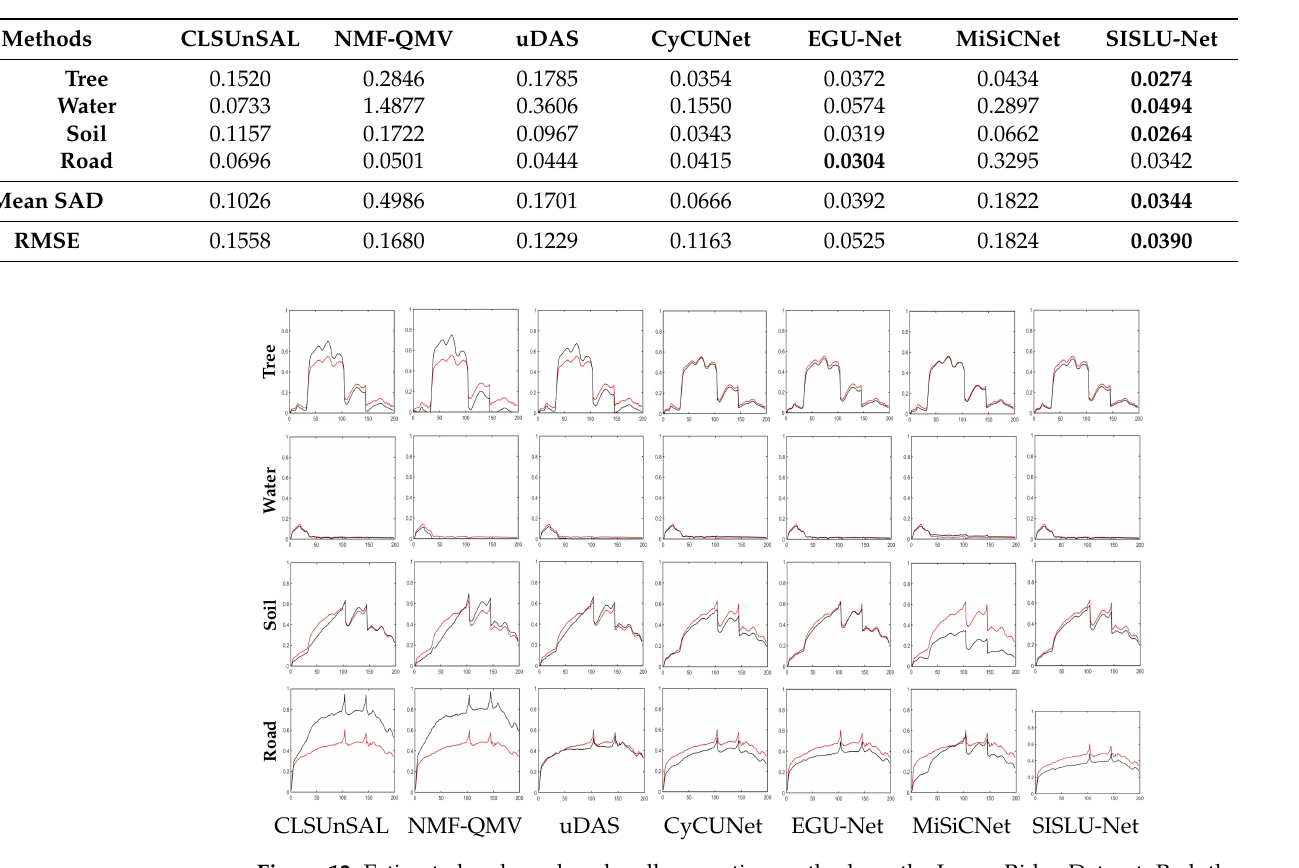
Figure 12. Estimated endmembers by all competing methods on the Jasper Ridge Dataset. Red: the ground truth endmembers; Black: the estimated endmembers.